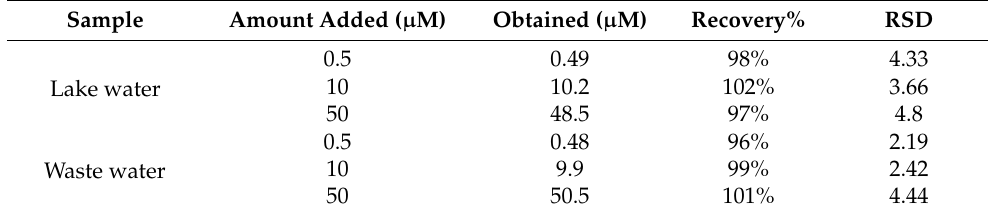
Table 1. Determination of AZA in Lake water and waste water